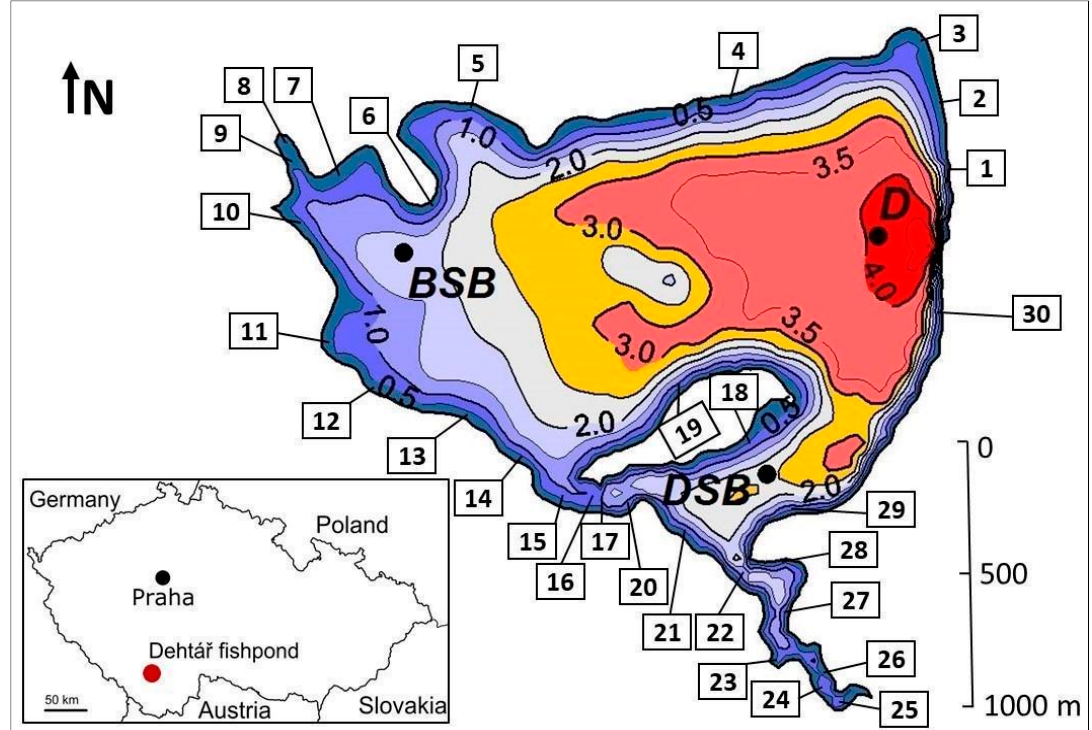
Figure 1. Location of the Dehtá ř fishpond and its particular study sites. The numbers show the mid-points of segments for the study of the flora of vascular plants and charophytes. The points show the position of high-frequency monitoring stations: D (=FD) = Fishpond dam, BSB = Babický stream bay, DSB = Dehtá ř ský stream bay; samples for water analysis and the analysis of epiphytic diatom assemblages were collected nearby. The two main inflows, Babický stream (BS) and Dehtá ř ský stream (DS), occur at the segments 8 and 25, respectively.